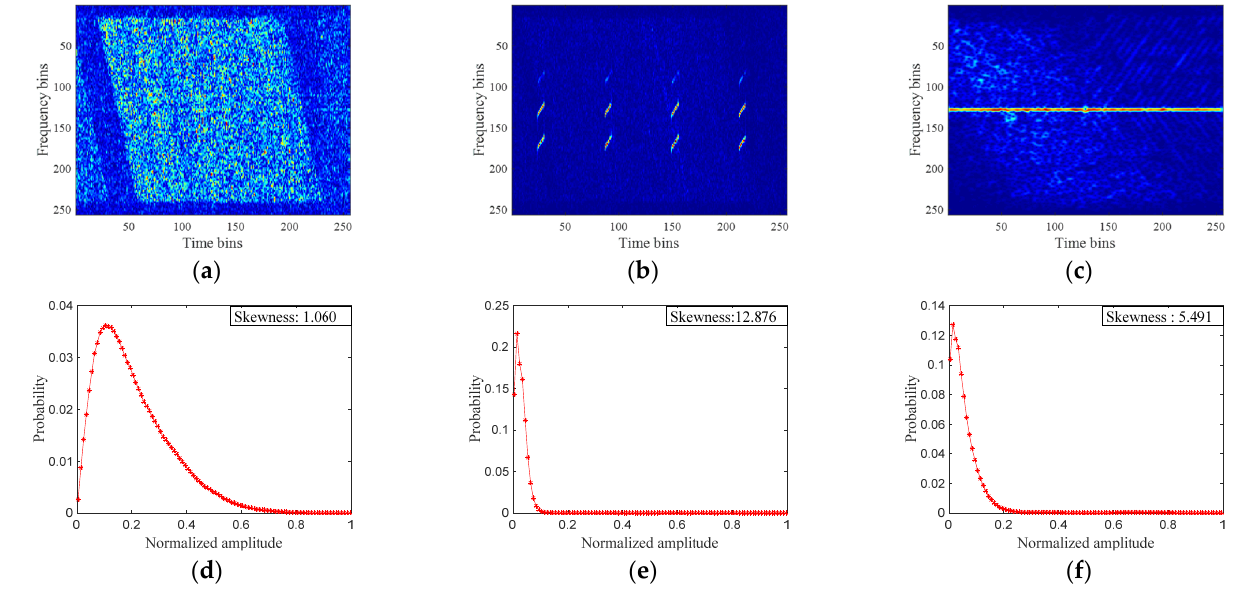
Figure 3. Statistical analysis of SAR echo spectrograms: ( a ) RFI-free signal; ( b ) WBI-corrupted signal; ( c ) NBI-corrupted signal; and ( d – f ) histograms and skewness, respectively, corresponding to ( a – c ).